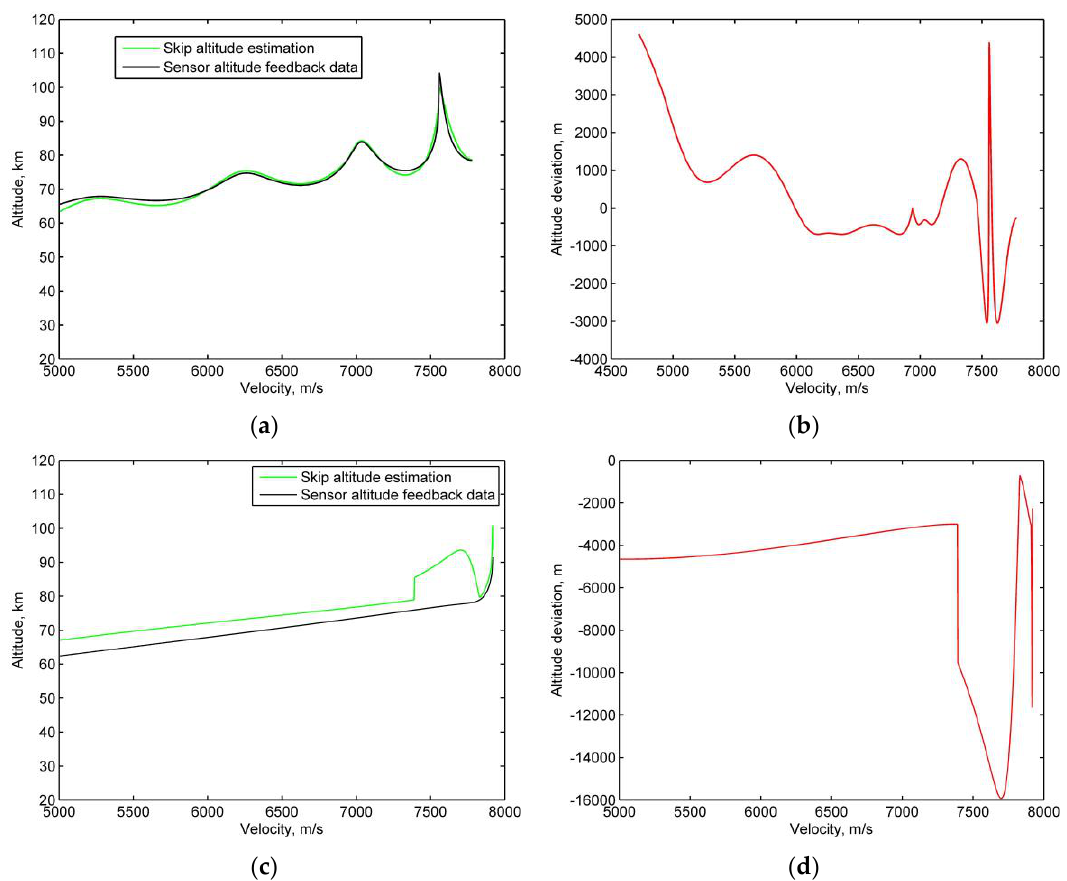
Figure 7. Comparison of the residuals between the skip re-entry and the quasi-equilibrium glide re-entry. ( a ) Skip altitude estimation vs. the sensor altitude feedback data in skip re-entry; ( b ) skip re-entry residuals between the skip altitude estimation and the sensor altitude feedback data; ( c ) skip altitude estimation vs. the sensor altitude feedback data during quasi-equilibrium glide re-entry; ( d ) quasi-equilibrium glide re-entry residuals between the skip altitude estimation and the sensor altitude feedback data.